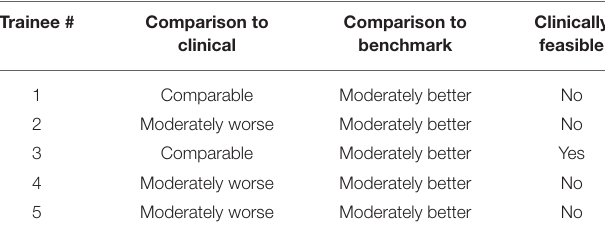
TABLE 4 | Physician evaluation of trainee post-training plan on 5-point scale (significantly worse to significantly better) and clinical feasibility rating. Trainee # Comparison to